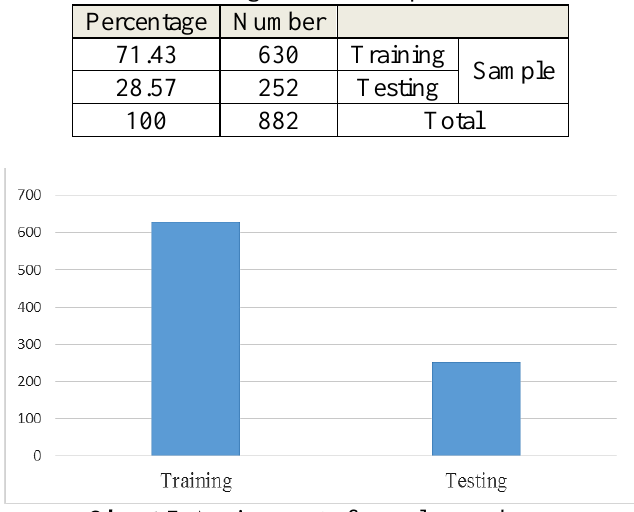
Table 10. Assignment of sample